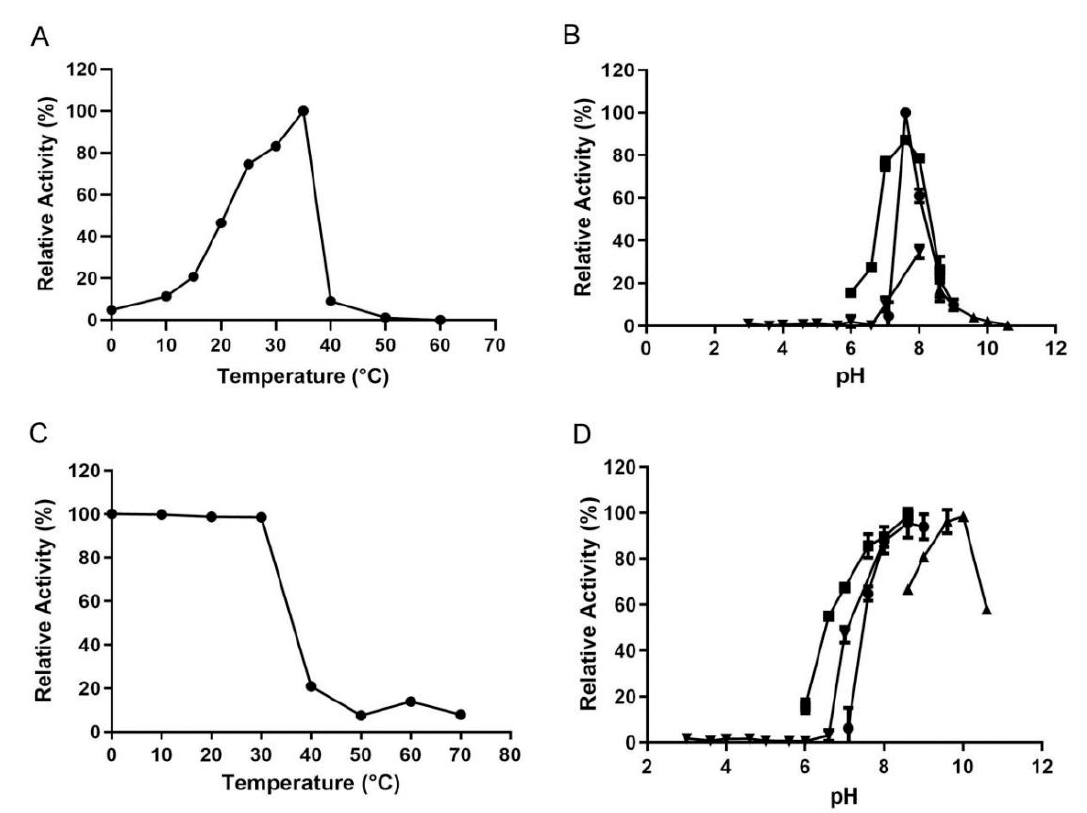
Figure 4. ( A ) The effects of temperatures on VsAly7D activities. ( B ) The optimal pH of VsAly7D in 20-mM buffer (inverted triangle, square, circle and regular triangle represent a citric acid–Na 2 HPO 4 buffer, Na 2 HPO 4 –NaH 2 PO 4 buffer, Tris–HCl buffer and Gly–NaOH buffer, respectively). ( C ) The thermostability of VsAly7D. ( D ) The pH stability of VsAly7D in 20-mM buffer (inverted triangle, square, circle and regular triangle represent a citric acid–Na 2 HPO 4 buffer, Na 2 HPO 4 –NaH 2 PO 4 buffer, Tris–HCl buffer and Gly–NaOH buffer, respectively).